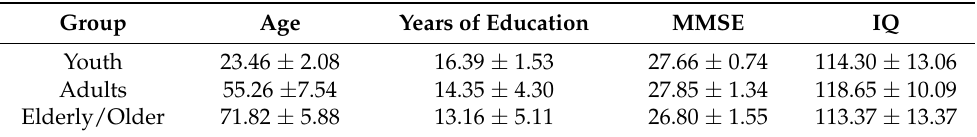
Table 1. Means and standard deviations of age, year of education, Mini-Mental State Examination (MMSE), and intelligence quotient (IQ) for each group of